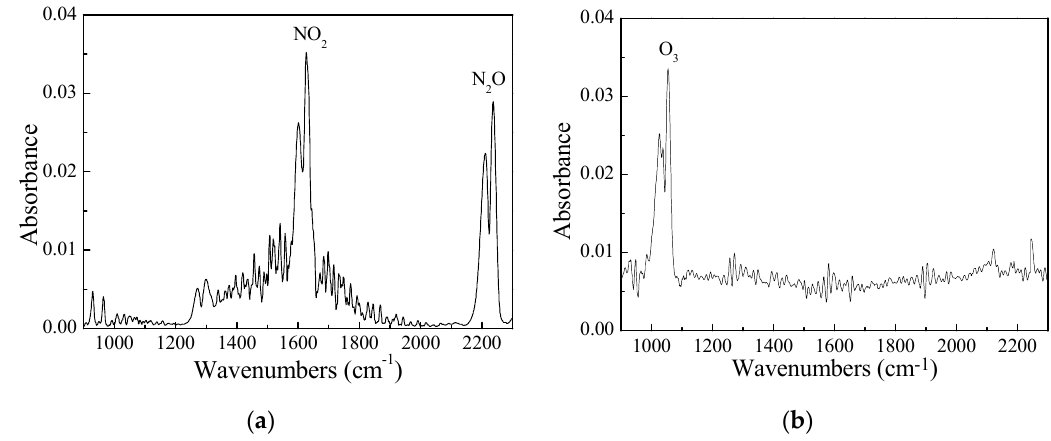
Figure 6. FTIR spectra of final products for the DBD-catalyst system with NH 3 /O 2 and N 2 /O 2 (reaction conditions: ( a ) 90 ppm NH 3 , 12% O 2 and balance N 2 ; ( b ) 12% O 2 and 88% N 2 ).